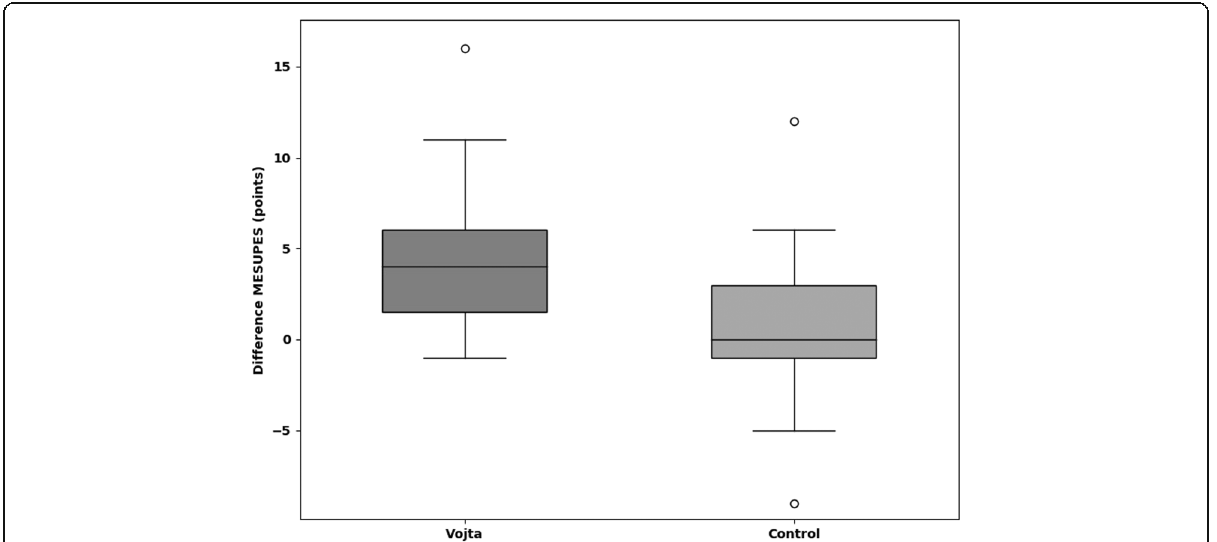
Fig. 4 Difference in motor evaluation scale for upper extremity in stroke patients (MESUPES) scale scores between baseline and day 9. The median improvement in the MESUPES within 9 days was 4 points (=20%) (IQR 1.5 – 6) in the Vojta group and 2 points (=10%) (IQR 0 – 5) in the control group ( p = 0.006). Data are presented as box-and-whisker plots